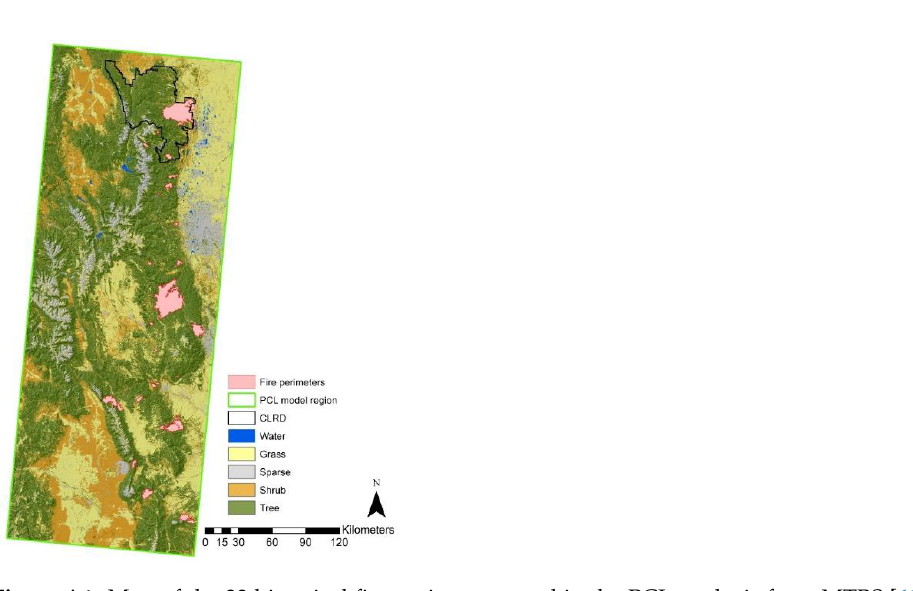
Figure A1. Map of the 33 historical fire perimeters used in the PCL analysis from MTBS [61] and GeoMAC [62]. Land cover is from LANDFIRE [51]. The spatial datum and projection are North America 1983 Albers Conic Equal Area.